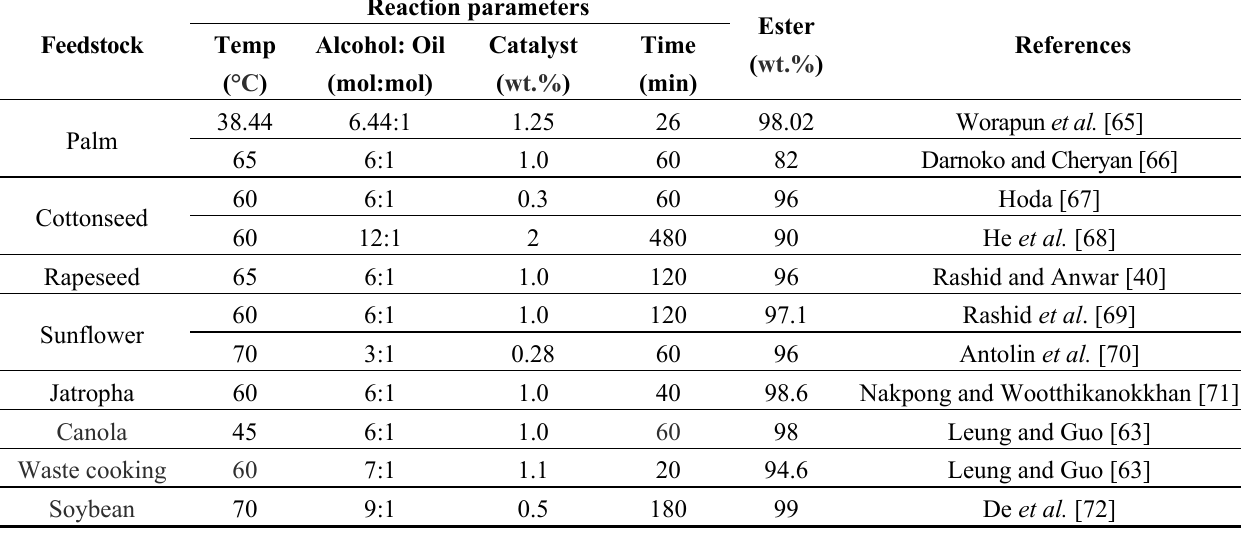
Table 3. Reported optimum conditions for transesterification of oils for biodiesel production. Reaction parameters Feedstock